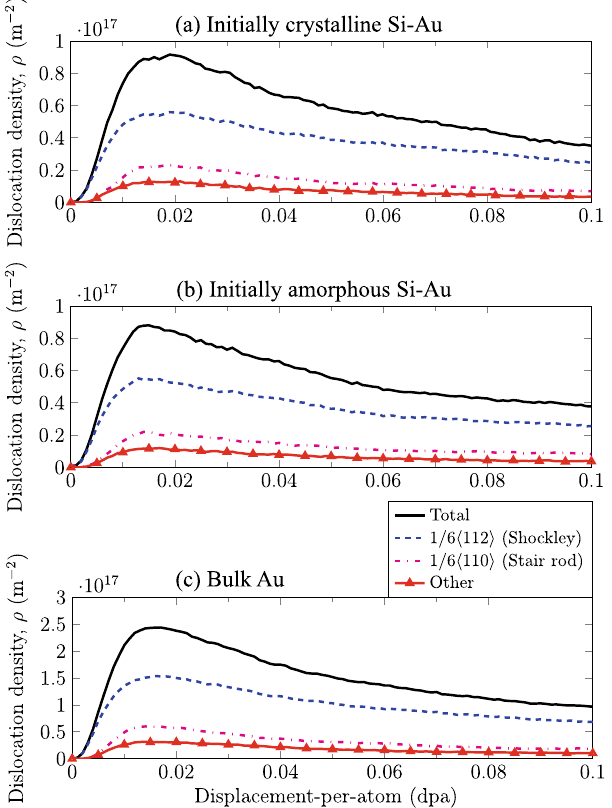
Figure 1. FCC Au dislocation density vs displacement-per-atom in ( a ) Crystalline Si–Au, ( b ) Amorphous Si–Au, and ( c ) Bulk Au. Dislocation density is calculated with respective to total simulation cell. Si–Au bilayers have the volume evenly split between Si and